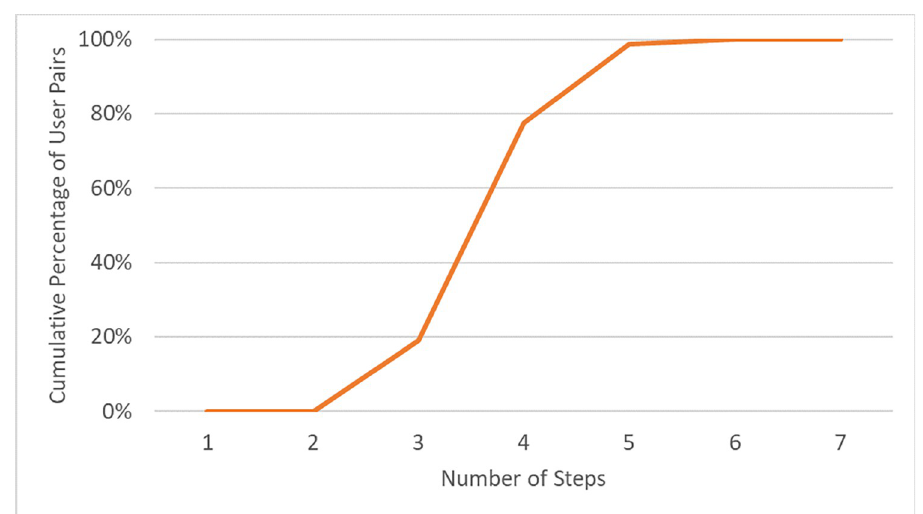
Fig 5. Cumulative percentage of user Pairs by number of steps.